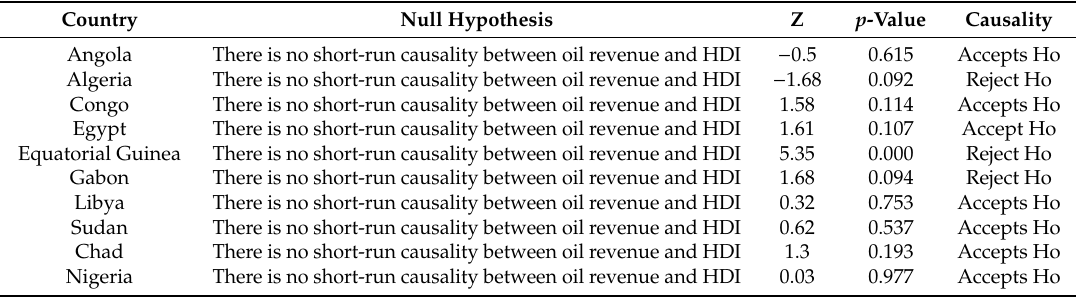
Table 16. Oil Revenue-HDI Causality